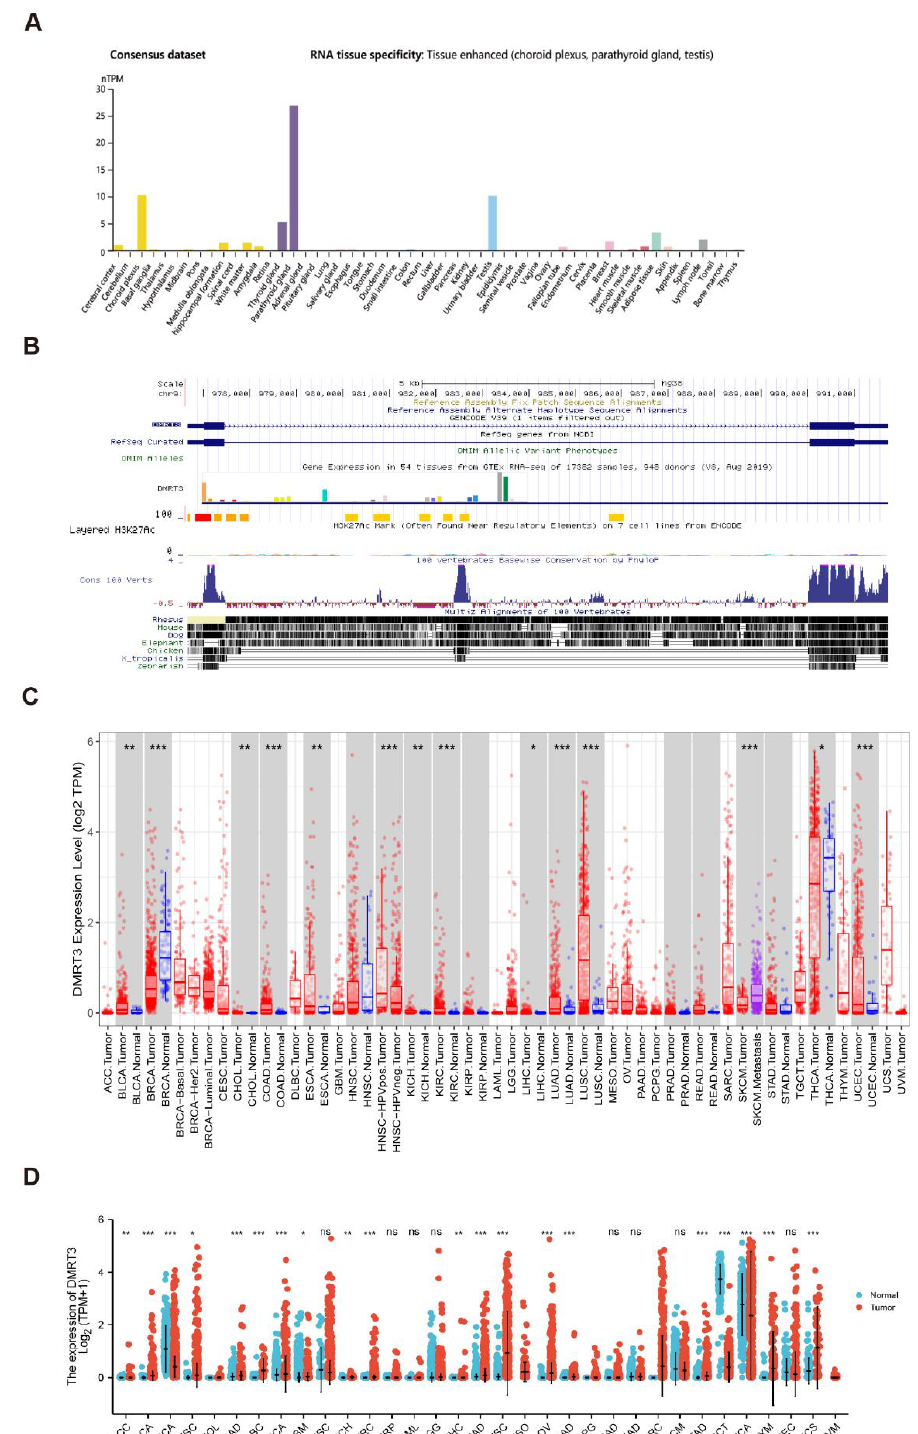
Figure 1. An analysis of the expression status of DMRT3 in tumors and normal tissues, as well as the conservation of the DMRT3 gene in vertebrates. ( A ) DMRT3 expression in pan-cancer (HPA database). ( B ) Visualization of the DMRT3 gene conserved analysis in vertebrates (UCSC database). ( C ) TIMER2 showing the expression status of DMRT3 in pan-cancer. ( D ) DMRT3 expression in pan-cancer (TCGA and GTEX database). Ns, p > 0.05; * p < 0.05; ** p < 0.01; *** p <